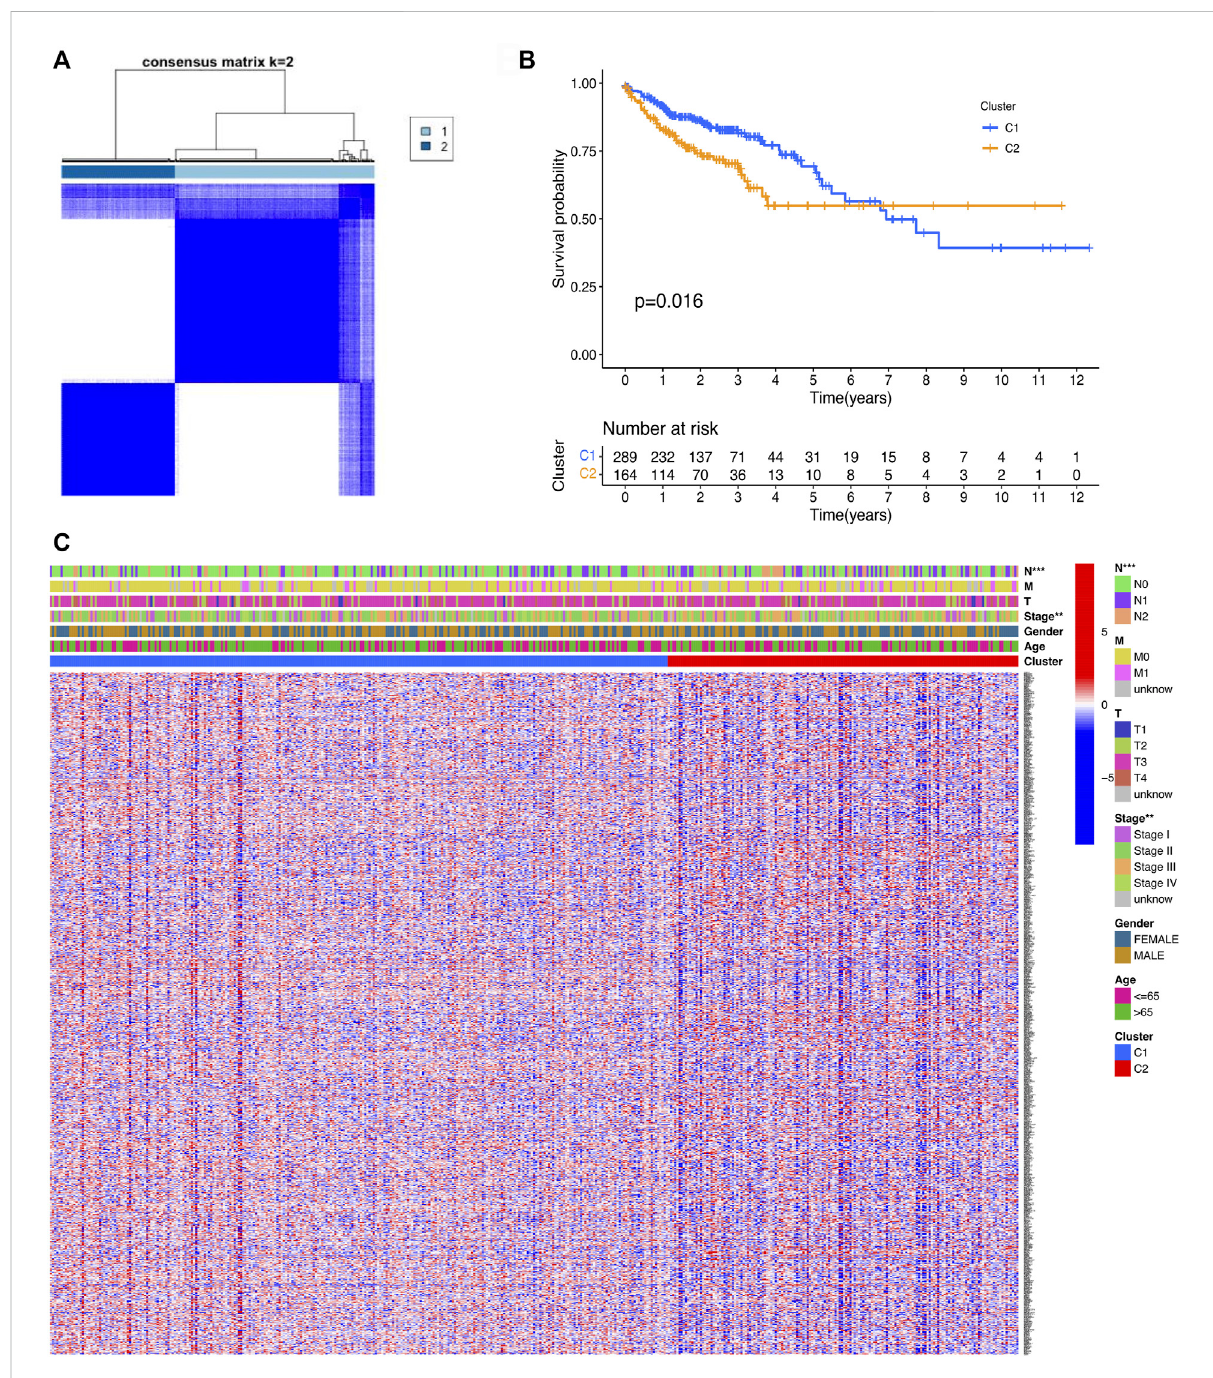
FIGURE 2 Classi fi cation of COAD patients based on the cuproptosis-related DEGs. (A) Total of 521 COAD patients were clustered into two clusters according to the consensus clustering matrix (k = 2). (B) KM curve for the two clusters. (C) Heatmap and the clinicopathologic features of the two clusters classi fi ed by the cuproptosis-related